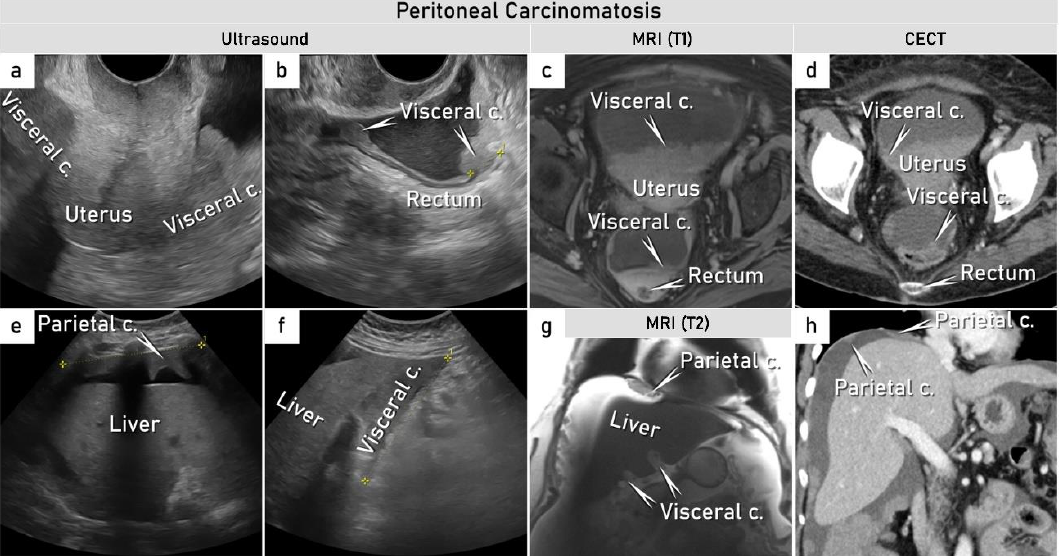
Figure 6. Cardiophrenic lymph node assessment using different imaging methods in high-grade serous cancer stage IVB. Ultrasound linear array probe (first column), axial WB-MRI: CE-T1WI-FS (contrast-enhanced T1-weighted imaging with fat suppression) (second column), WB-MRI (fusion with DWI): Fusion of DWIBS (diffusion-weighted imaging with background body signal suppression) + CE-T1WI-FS (third column) and CECT (fourth column) are demonstrating metastatic cardiophrenic lymph node of 7 mm marked with arrow on ultrasound ( a ) and circle on MRI ( b , c ) and CECT ( d ). This is the same case as presented in Figure 4. CE, contrast-enhanced; CT, computed tomography; DWI, diffusion-weighted imaging; FS, fat suppression; WB-MRI, whole-body magnetic resonance imaging.